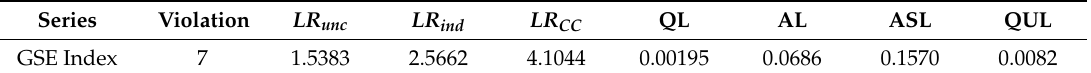
Table 4. Backtesting coverage test statistics and loss function scores.